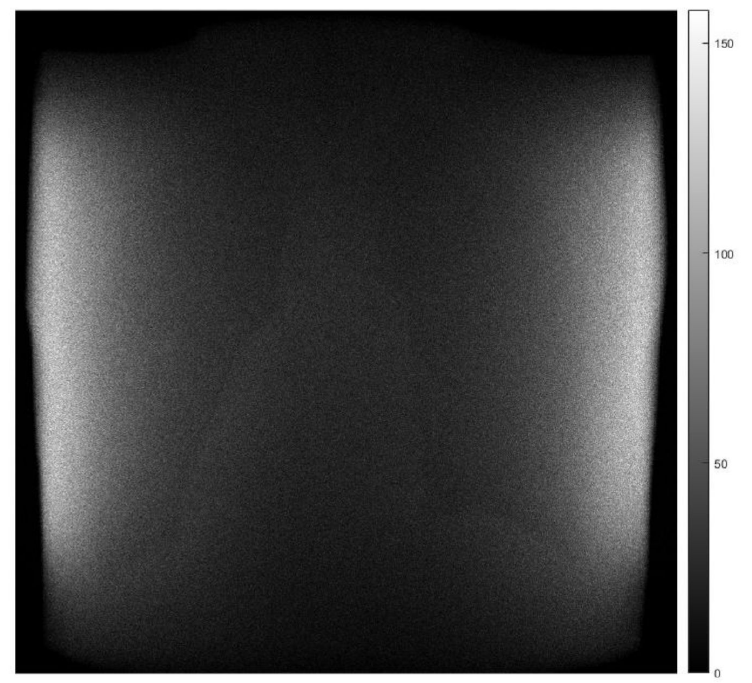
Figure 9. Fluorescence image for 0.5 mg/mL of